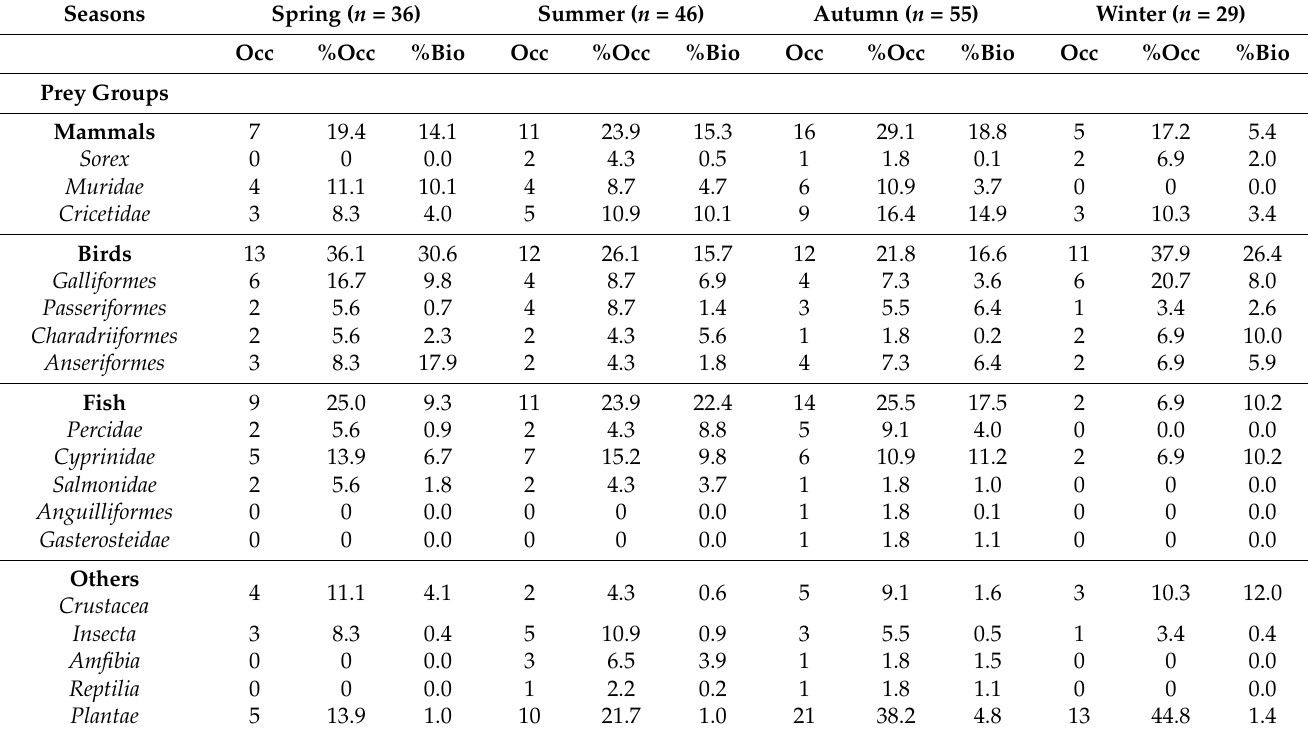
Table 4. Occurrence (Occ), percentages of occurrence (%Occ), and percentages of biomass (%Bio) for mink ( n = 166) and mink during the seasons: spring ( n = 36), summer ( n = 46), autumn ( n = 55) and winter ( n =